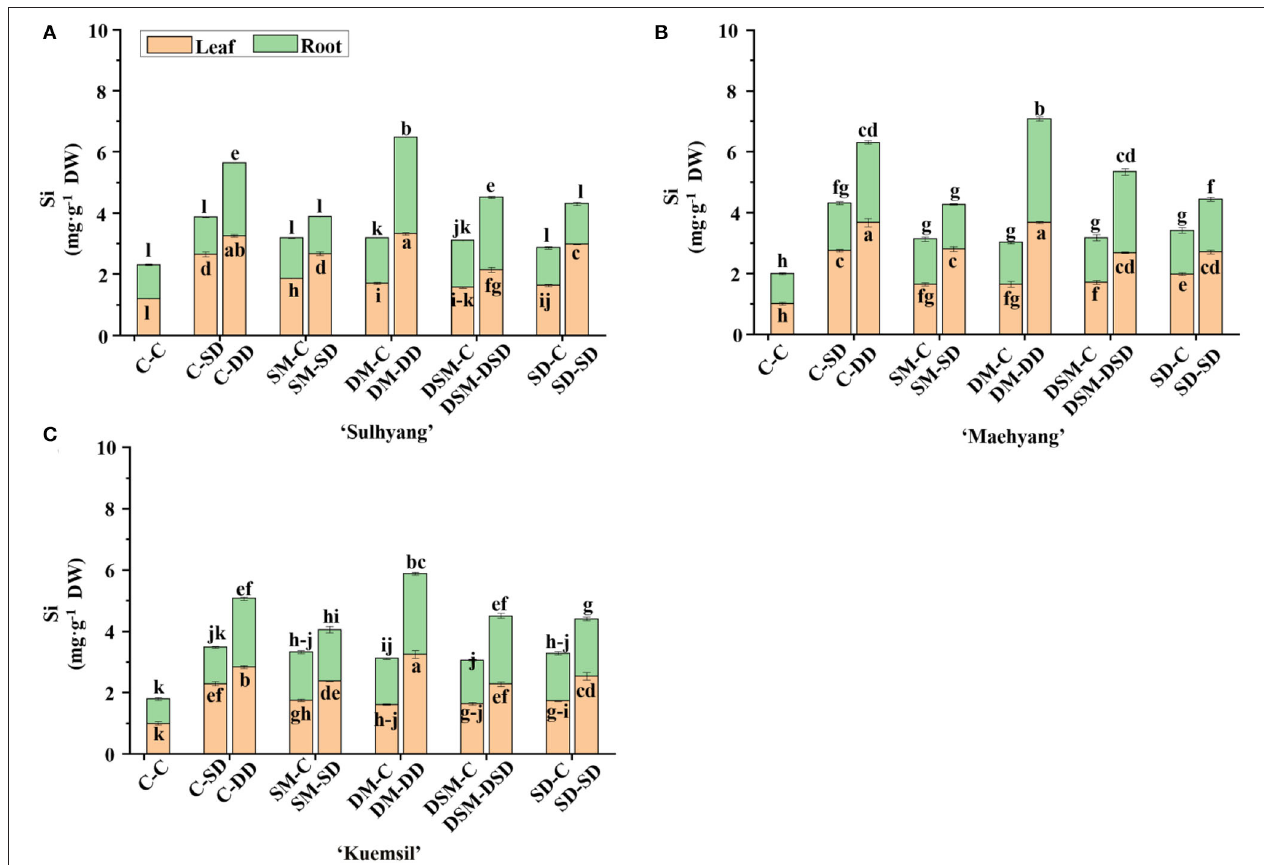
FIGURE 8 | The Si content in leaves and root of strawberry transplants (A) “Sulhyang”; (B) “Maehyang”; and (C) “Kuemsil” as affected by the Si treatments subjected to 43 ◦ C for 7 days. Lowercase letters indicate significant differences calculated by the Duncan’s multiple range test at p ≤ 0.05. See Figure 1 for descriptions of treatment